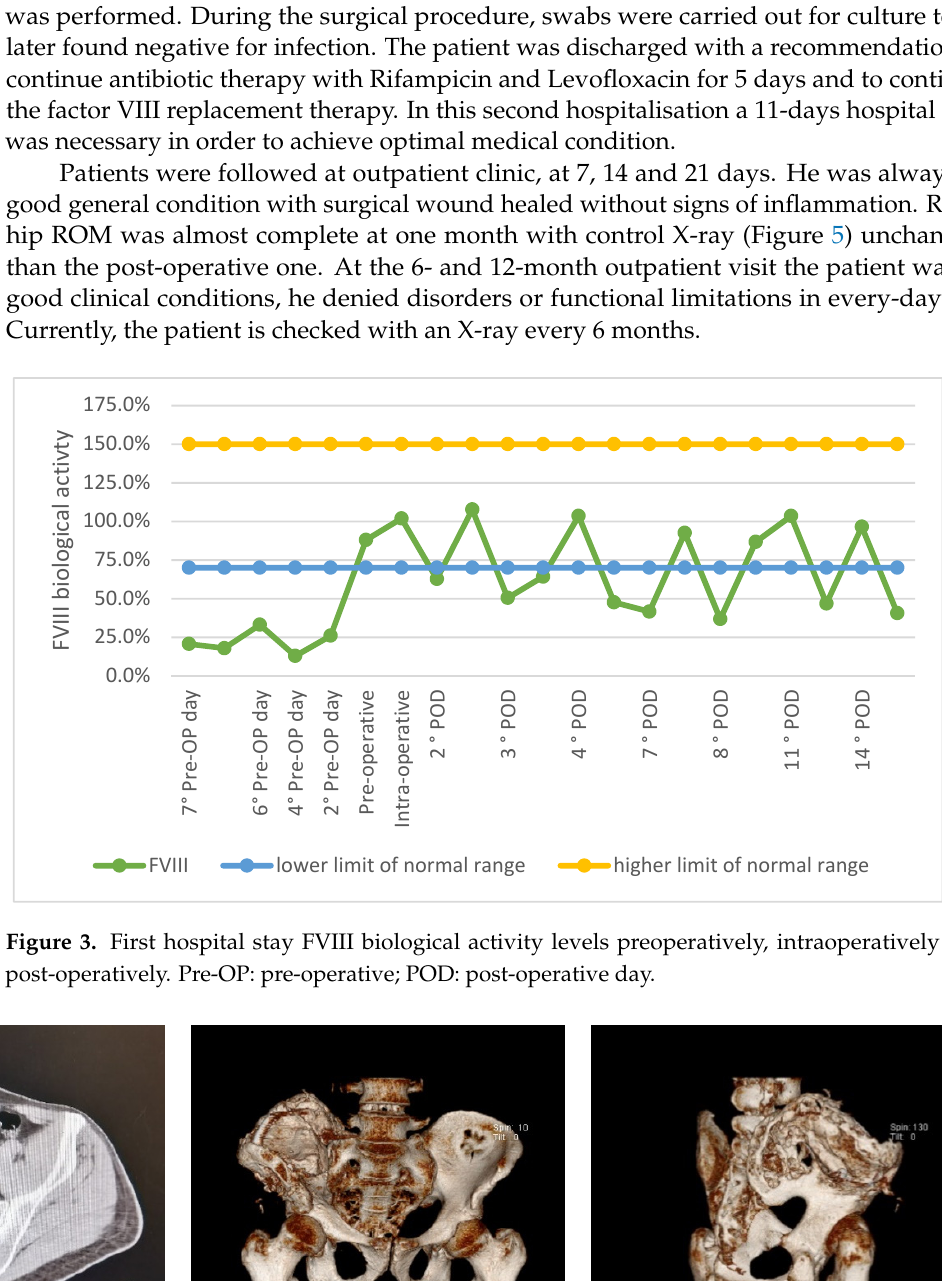
Figure 5. One-month post-operative radiograph control. The patient continued prophylaxis with pd-FVIII 30 IU/Kg three times a week. No further bleeding manifestations occurred. 3. Discussion Pseudotumour is an uncommon but potentially severe debilitating complication of bleeding disorders like haemophilia. Pseudotumour is a chronic encapsulated haematoma that is not resorbed and continues to expand due to recurrent haemorrhages [6] develop- ing a tumour-like form: capsulated masses containing coagulated blood and necrotic tis- sue [2]. The bleeding can arise spontaneously or, as in the case here reported, as a conse- quence of trauma. Gilbert distinguished two types of pseudotumour based on location; the proximal type, seen most commonly in adults, occurs in the pelvis (especially in the ilium), and long bones extremities; in children there is a predilection for distal pseudotumours that occur in the small bones of the hands and feet [3]. Regarding the involvement of soft tissues, pseudotumours mainly affect those of the thigh, the gluteal region and the iliopsoas muscle, with possible simultaneous bone in- volvement. Muscular pseudotumours can be classified as intra- or extra-muscular. Usually, in- tramuscular lesions remain localised, although they can sometimes expand towards the bone component. Pelvic haemophilic pseudotumours that develop after bleeding into the psoas or illiacus muscles may grow quite large and cause significant erosion of adjacent bone [7], like in our case.